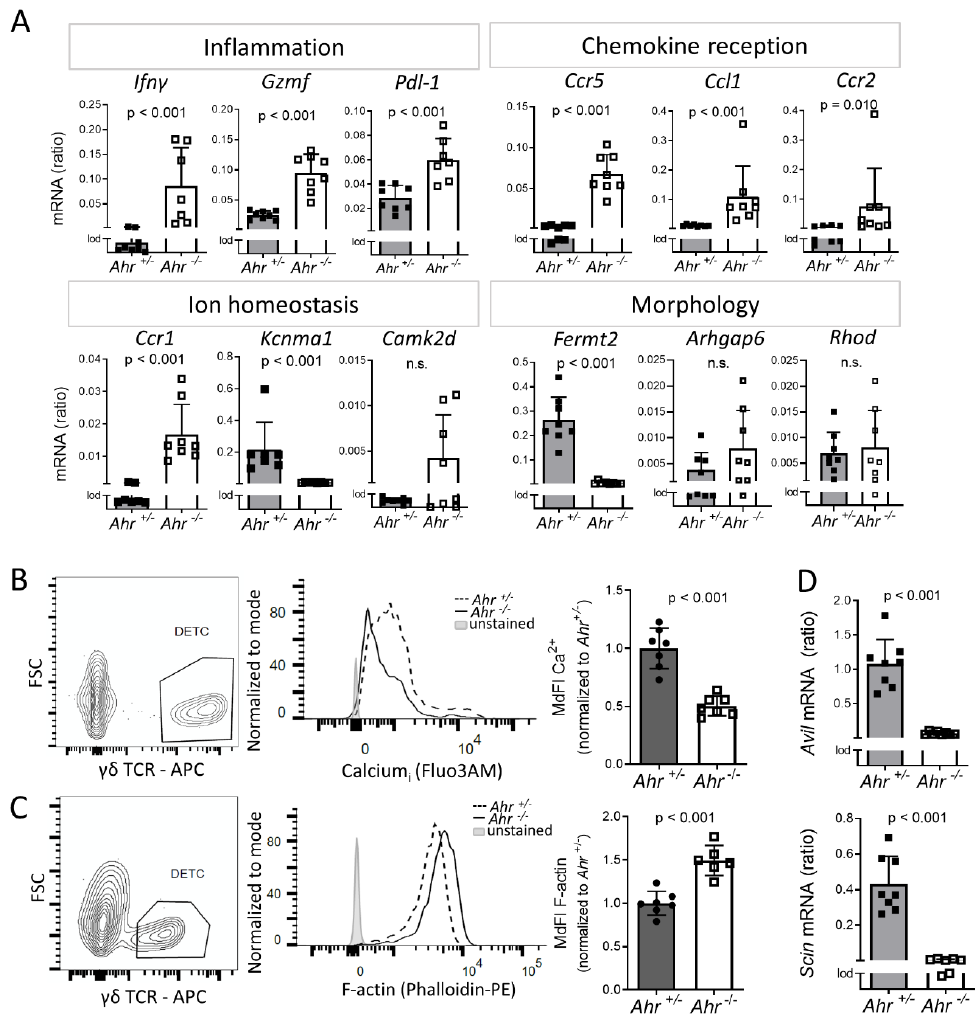
Figure 3. Verification of gene-expression and effects of Ahr-deletion in DETC on calcium and F-actin. ( A,D ) RNA of DETC, FACS-sorted from 2 weeks old mice was isolated. Expression of indicated genes was measured by qPCR; shown are ratios to the housekeeper gene Rps6 ( n = 8 mice; t-test for Gzmf , Pdl1 , Ccr5 , Rhod, Avil, Scin ; Mann – Whitney-test for remaining genes). ( B ) epidermal cells were isolated from 4 – 8 weeks old mice, stained with Fluo3AM and antibodies against γδ TCR and analyzed by flow cytometry; shown are the median fluorescent intensities of Fluo3AM (MdFI) normalized to Ahr +/- mice. Dead cells were excluded by DAPI-staining (3 experiments, n = 7 mice). ( C ) epidermal cells were isolated from 8 – 11 weeks old mice, stained with phalloidin- PE and antibodies against γδ TCR and analyzed by flow cytometry; shown are the median fluorescent intensities of phalloidin (MdFI) normalized to Ahr +/- mice (2 experiments, n = 6 – 7 mice ( B,C ) statistical test: Mann – Whitney-test. To determine whether these effects were due to intrinsic AHR-deletion or might be induced by surrounding AHR-deficient cells. Ahr -flox-K5-cre x Ahr -flox-LC-cre mice carrying an Ahr -deletion only in keratinocytes and Langerhans cells had normal amounts of DETC (Supplementary Figure 1C). Furthermore, DETC of Ahr -flox-K5-cre mice showed no similarities to DETC of Ahr -/- mice in the up-regulation of Ifnγ and Gzmf or down-regulation of Scinderin and Kcnma1 (Supplementary Figure 1D). Finally, ablating AHR in γδT cells of adult mice using a mouse line with a tamoxifen